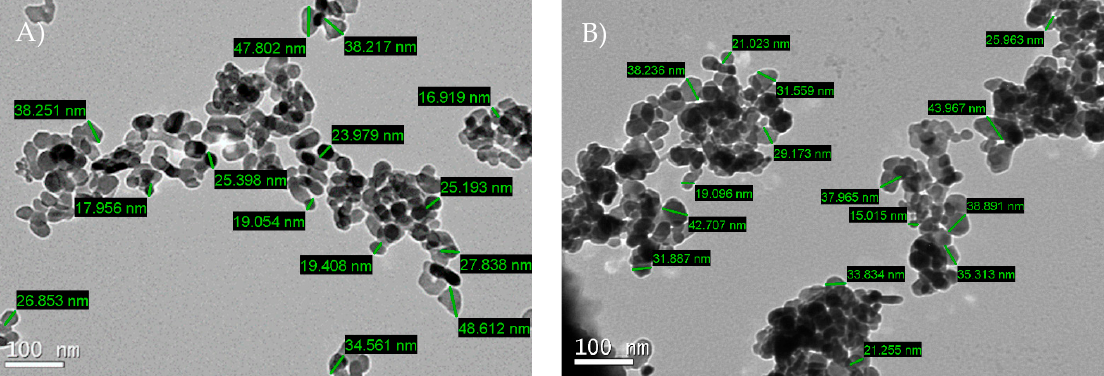
Figure 1. Nano-TiO 2 ( A ) and nano-ZnO ( B ) micrographs obtained by transmission electron microscopy technique.